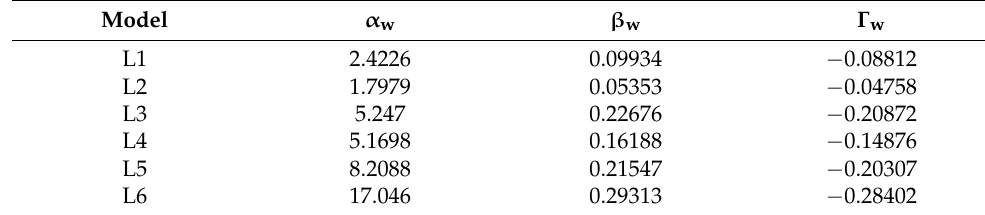
Table 3. Weibull PDF parameters for different load models [24].